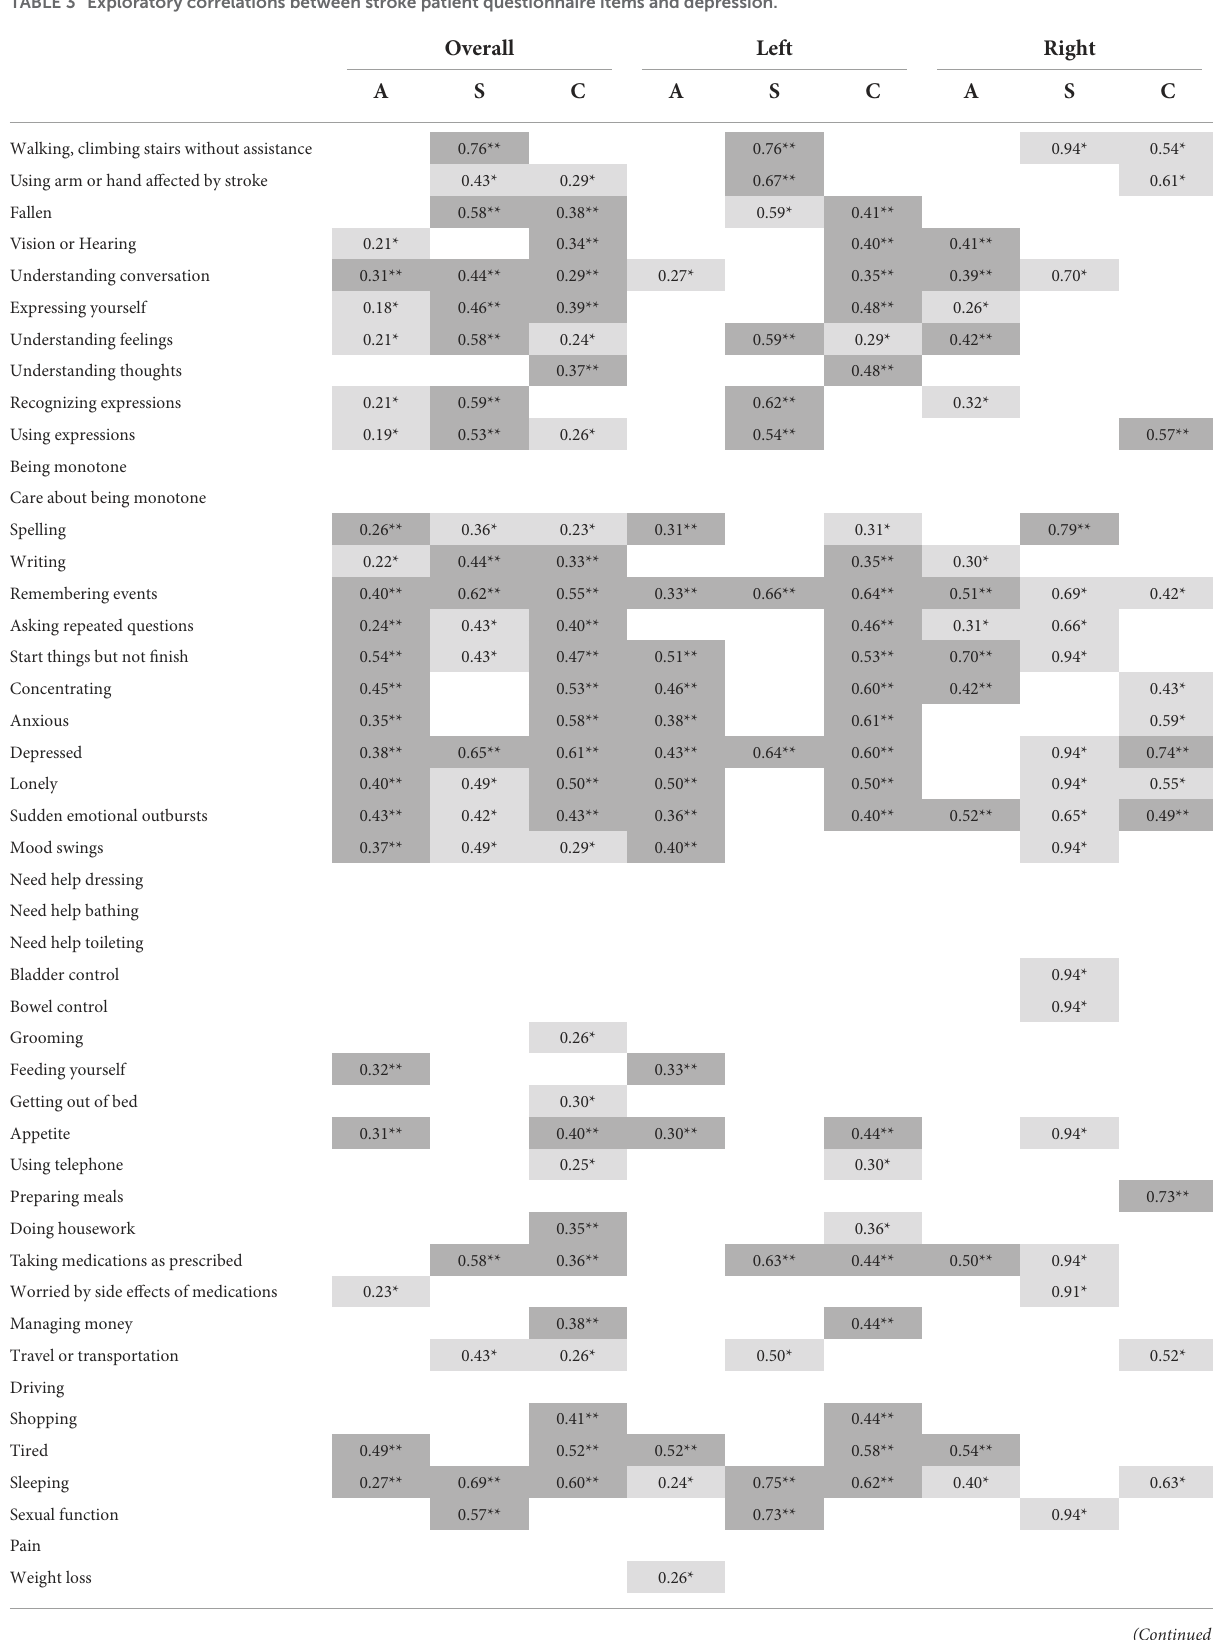
TABLE 3 Exploratory correlations between stroke patient questionnaire items and depression.